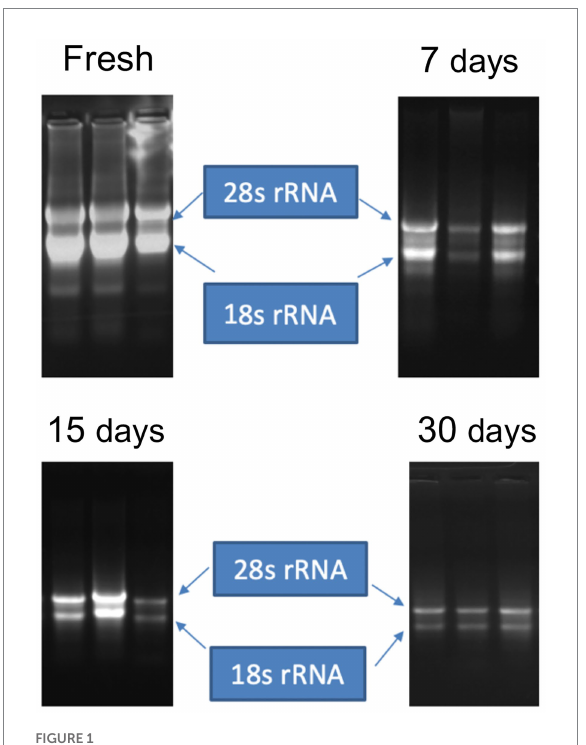
FIGURE 1 Gel electrophoresis of total RNA extracted from fresh leaves or leaves harvested and stored in RNA later ® for 7, 15 or 30 days. Bands corresponding to intact ribosomal RNA (rRNA) species are shown.